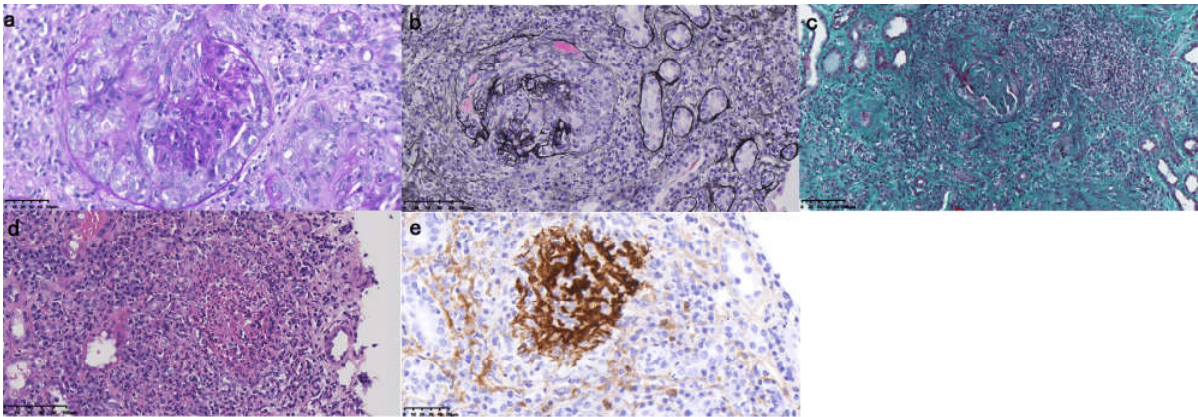
Figure 1 . The pathologic features of renal biopsy. Cellular crescent formations of the glomeruli were observed with periodic acid-Schiff (PAS) staining in light microscopy (( a ); 400×). Neutrophil infiltration and diffuse interstitial fibrosis in the interstitium, as well as focal tubular atrophy, were found with periodic acid-silver methenamine (PASM) and Masson staining (( b , c ); 400×). Focal neutrophil infiltration and small abscess formation were revealed by hematoxylin-eosin (HE) staining (( d ); 400×). Immunohistochemical staining showed IgG3 deposited along capillary walls (( e ); 400×). Given the positivity of the double antibody and the formation of a pathologically